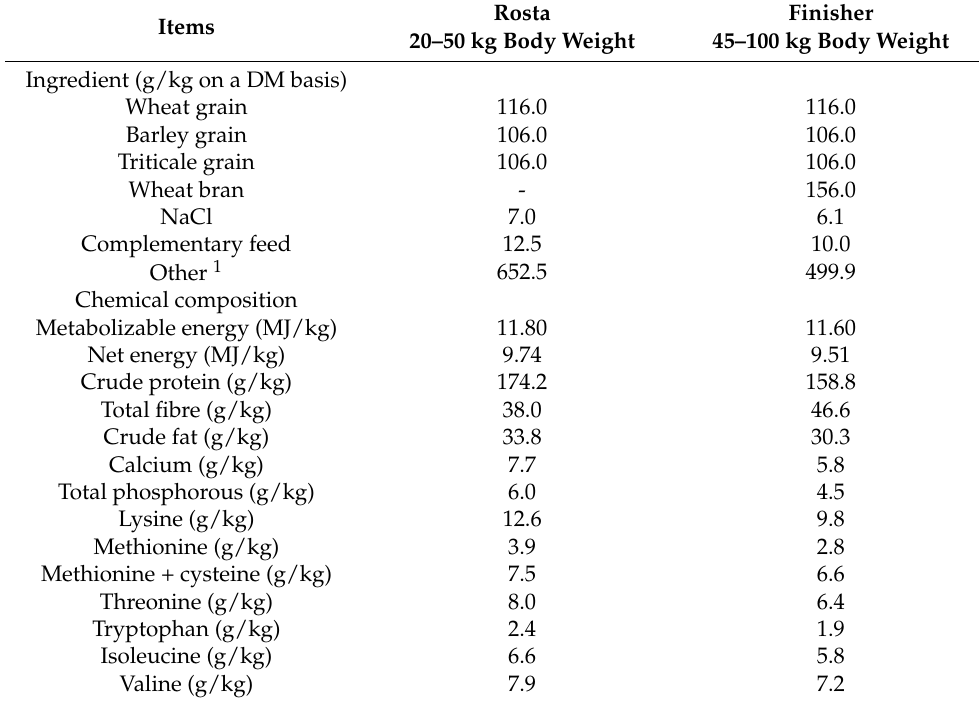
Table 1. Composition of the experimental